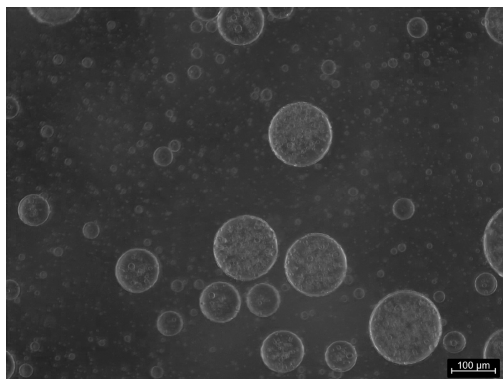
Figure 9. Typical microscope image of an emulsion stabilized by CG at 6.2 × 10 − 4 M, where the composite feature of the disperse phase is evident.